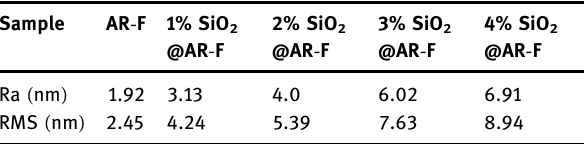
Table 2: Surface height map of di ff erent SiO 2 content adhe - sive fi lms